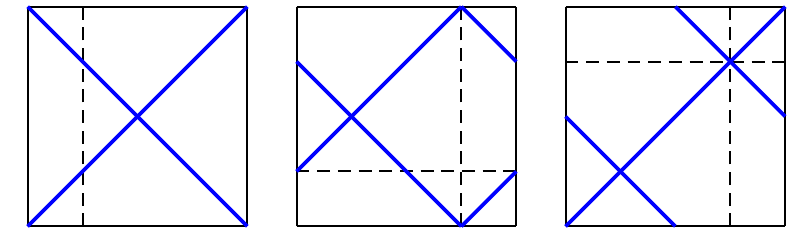
Figure 5: The supports of E 0 , S 1 * E 0 and E 1 (cid:17) S 1 * E 0 * S T 1 respectively